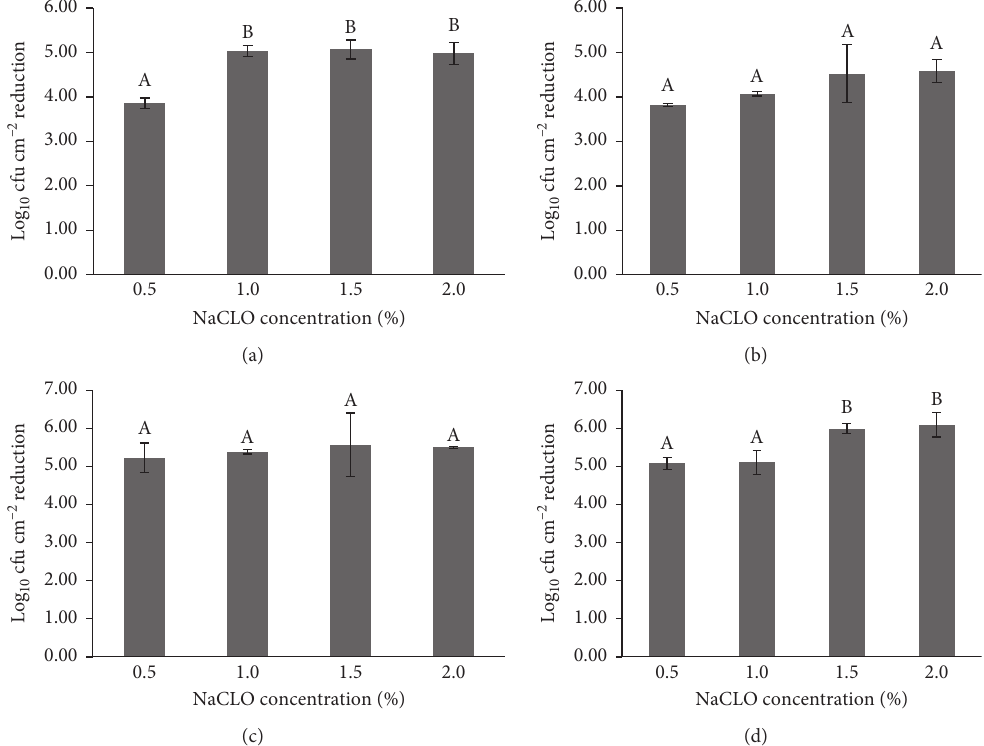
Figure 7: Number of biofilm cells reduced on the Rosa Porrino after 5 (a), 10 (b), 15 (c), and 30 min (d) of sodium hypochlorite treatment.